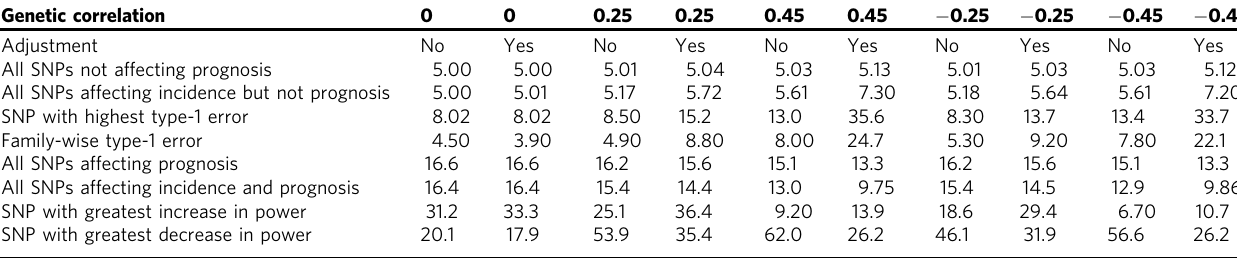
Table 2 Power for quantitative incidence and prognosis without non-genetic confounding Genetic correlation